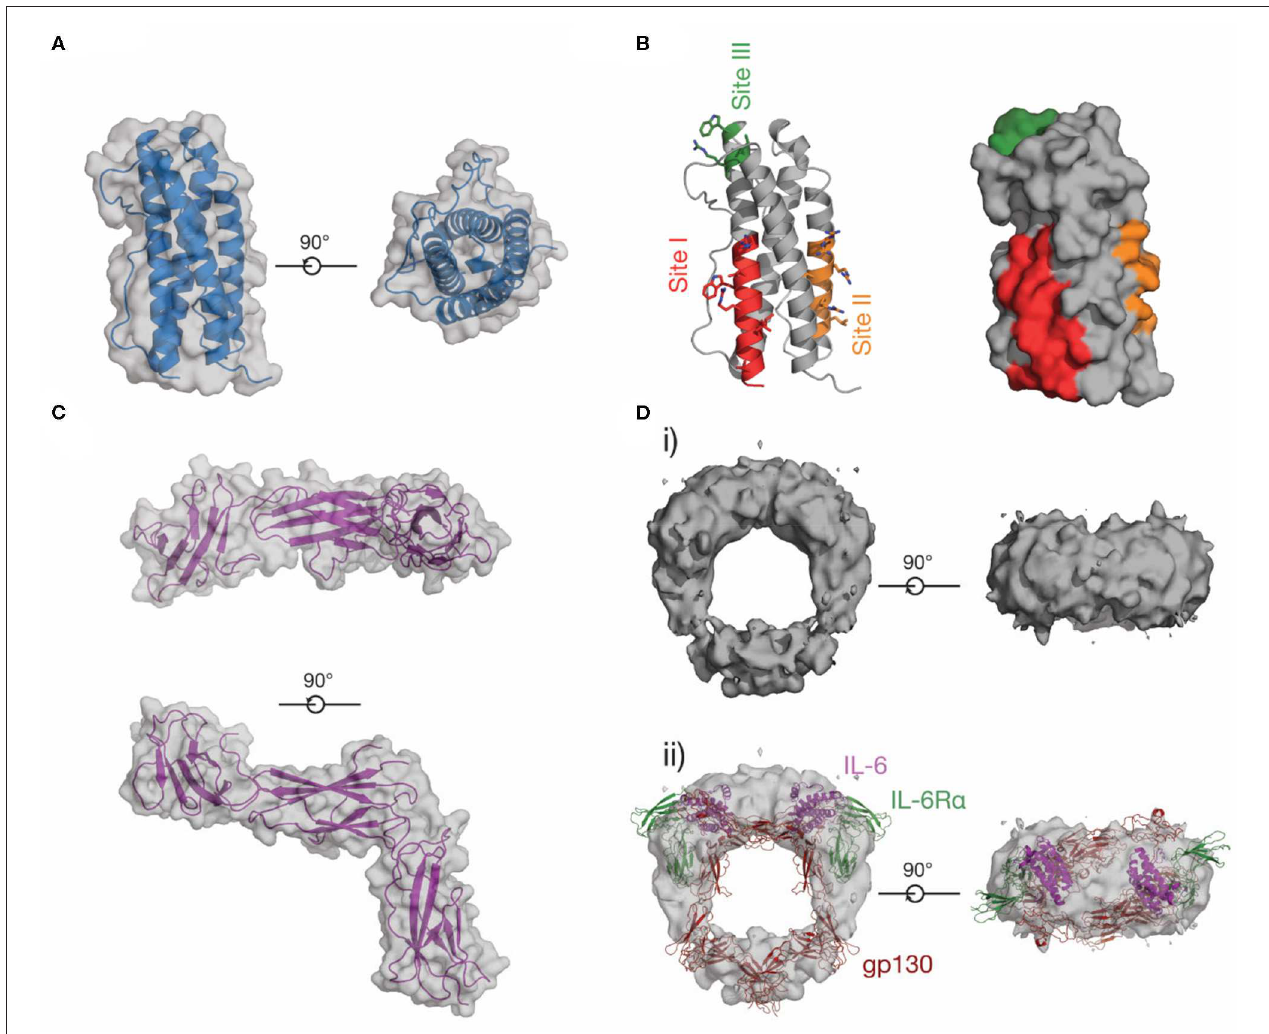
FIGURE 6 | The structure of IL-11. (A) Two views of the structure of IL-11 [PDB ID: 6O4O (174)]. (B) Receptor-binding sites on IL-11, which have been identified through mutagenic studies on human and mouse IL-11. (C) Two views of the structure of the extracellular domains of IL-11R α [PDB ID: 6O4P (174)]. (D) A low-resolution EM map of the extracellular IL-11 signaling complex [EMD-1223 ( 128)] (i), additionally shown overlaid with a model of the extracellular IL-6 signaling complex, (ii) [generated from PDB IDs: 3L5H ( 58), 1P9M